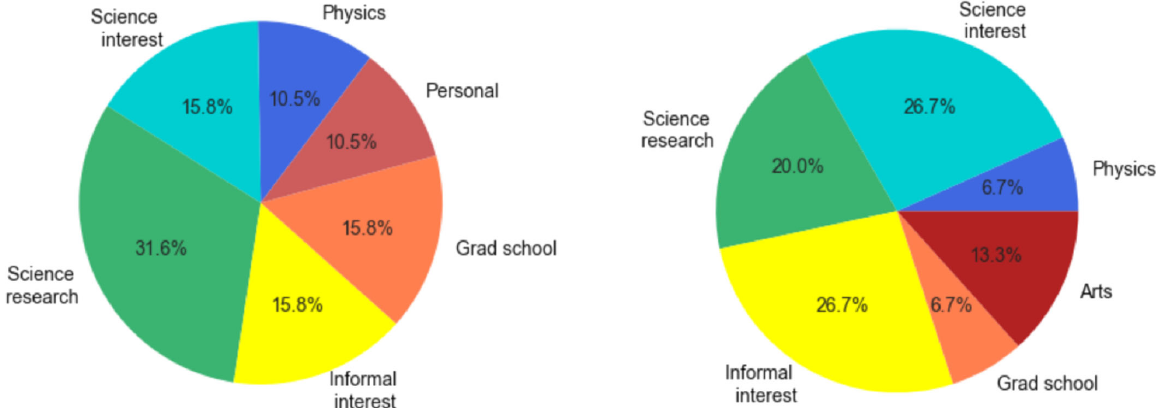
FIG. 2. Percentage of overlap between PCA and other communities (out of total percentage of overlapping areas for PCA) for Cecilia (left) and Mike